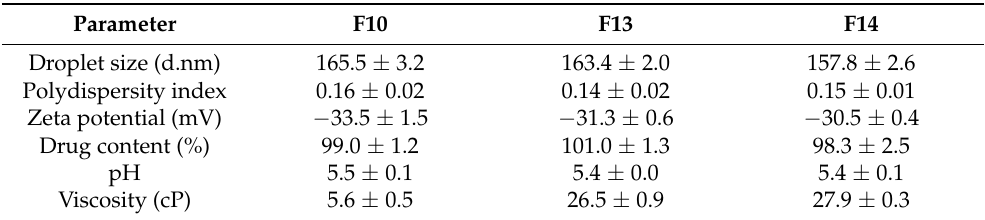
Table 4. Droplet size, PDI, zeta potential, drug content, pH, and viscosity of F10, F13, and F14 formulations (mean ± SD, n =